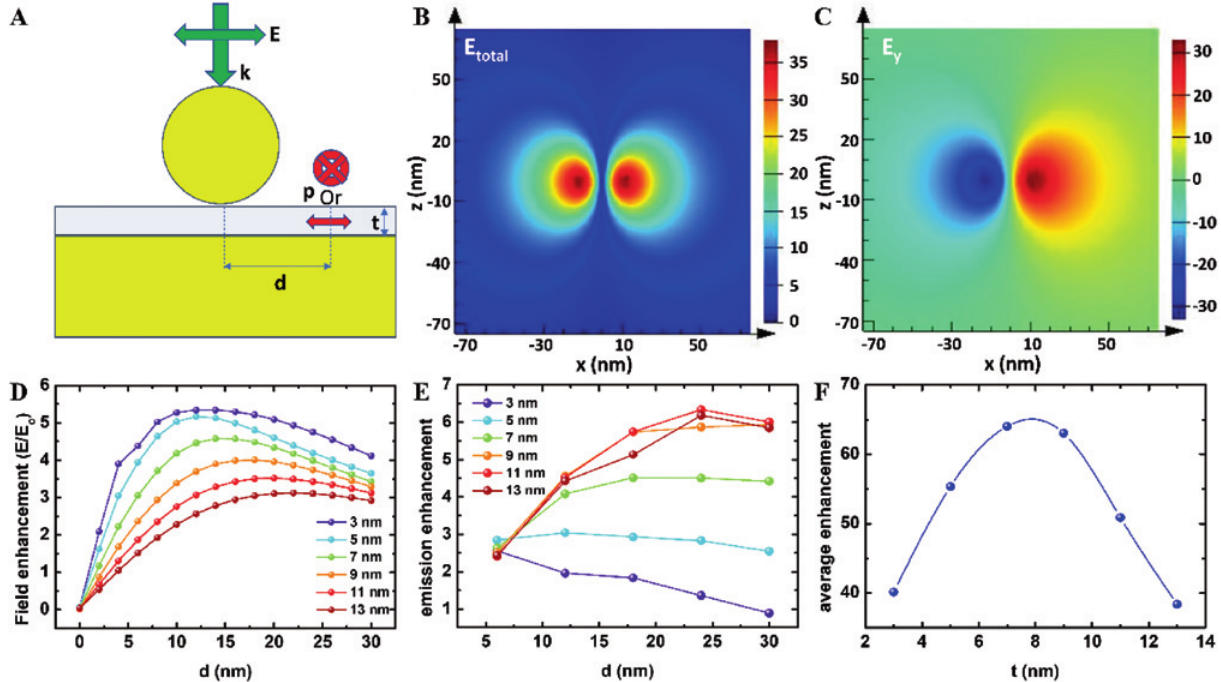
Figure 4: (A) Schematic diagram of AuNP – AuFilm simulation, green arrows indicate the direction of excitation and polarization of the 532 nm laser, while red arrows indicate electric dipole polarization. (B) Near-field distribution of the middle region of the dielectric spacer at 532 nm excitation. (C) Near-field distribution of the out-of-plane field component. (D) Local field amplitude enhancement at 532 nm. (E) Dipole emissionenhancementat650nm.(F)AverageemissionenhancementoftheAuNP –